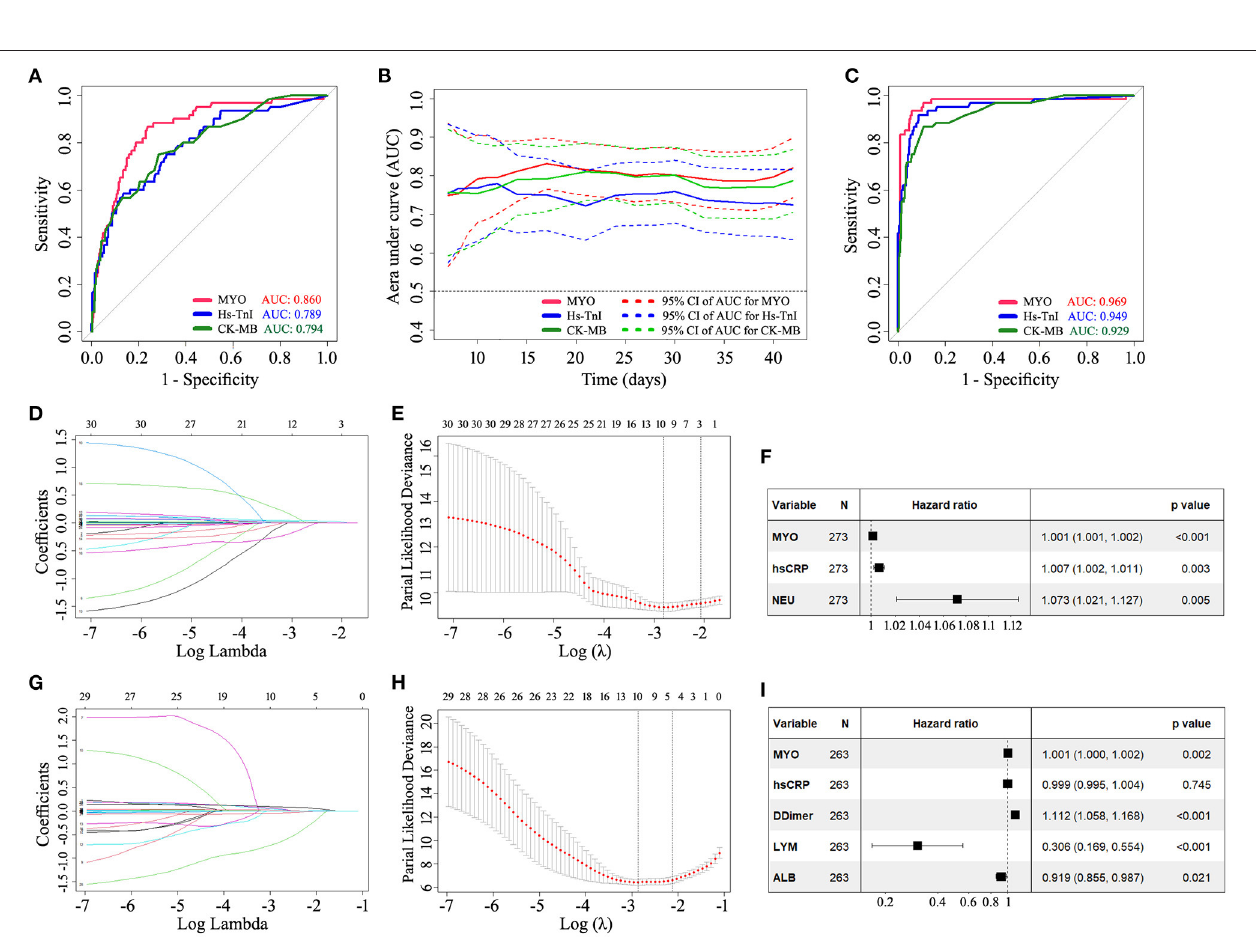
FIGURE 5 | Subgroup analysis demonstrating the prognostic ability of MYO in COVID-19 patients with severe or critical conditions. The results confirmed that MYO provided a better prognostic performance than hs-TnI and CK-MB and had an independent prognostic effect on in-hospital mortality. (A) Standard ROC curve analysis based on the early-stage levels of biomarkers. (B) Time-dependent AUC curves based on the early levels of cardiac markers. (C) Standard ROC curve analysis based on the late-stage levels of biomarkers. (D–F) LASSO regression and multivariate COX analysis based on early levels of biomarkers. (G–I) LASSO regression and multivariate COX analysis based on late levels of biomarkers. LASSO, least absolute shrinkage and selection operator; MYO, myoglobin; NEU, neutrophil; hs-CRP, high sensitivity C-reactive protein; LYM, lymphocyte; ALB, albumin; N, number; AUC, area under